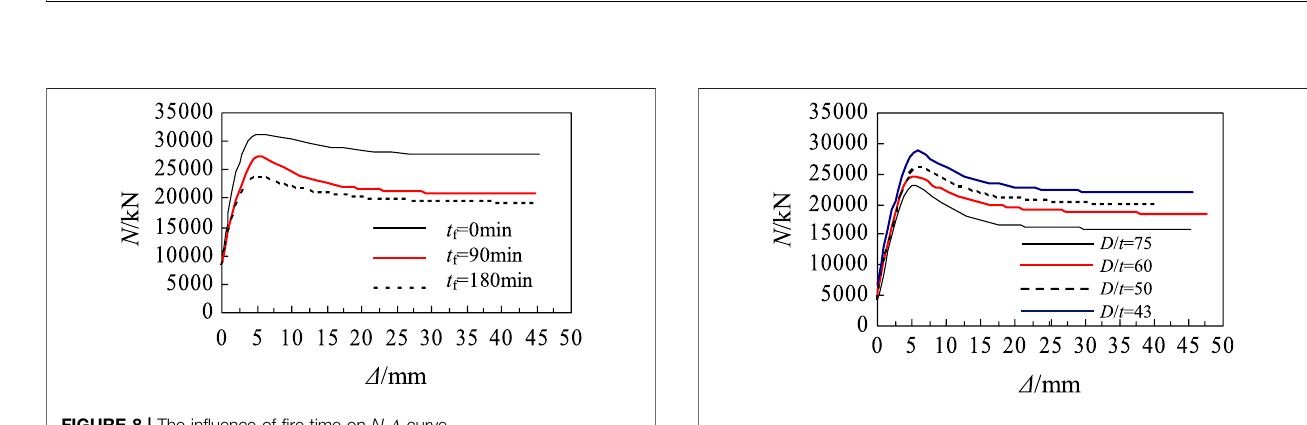
FIGURE 7 | Change of contact stress between steel tube and concrete. (A) Heating and cooling stage. (B) Post- fi re loading stage.